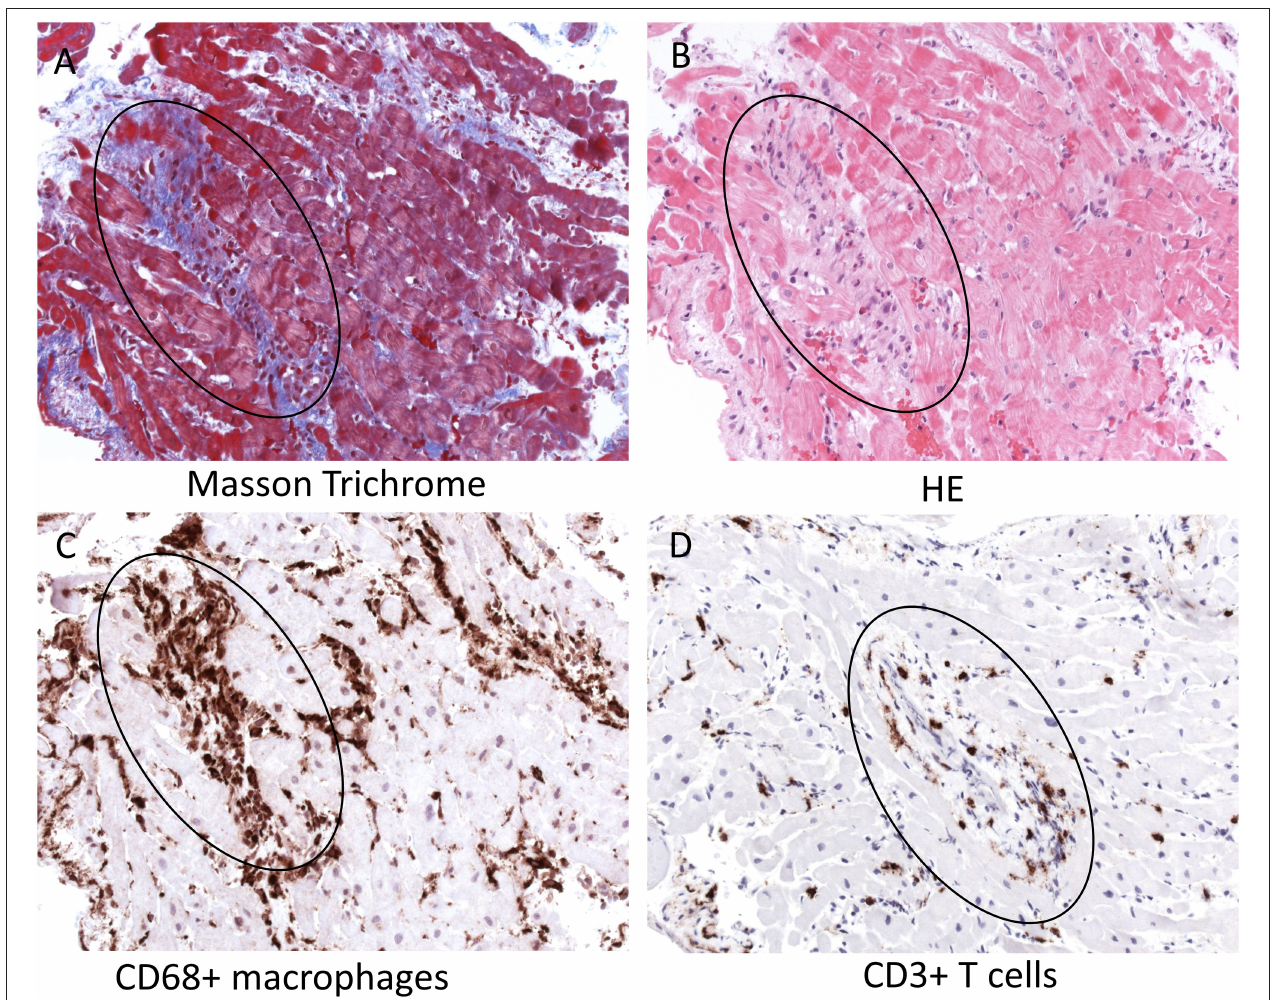
FIGURE 2 | Histopathology and immunohistochemistry of the patient’s endomyocardial biopsy. Serial tissue sections of paraffin-embedded endomyocardial biopsies reveal perivascular fibrosis in absence of myocyte necrosis [Masson Trichrome (A) and HE (B) stainings, see circle] and severe infiltration of CD68 + macrophages (C) and CD3 + T cells (D) primarily around intracardiac small vessels (see circle, magnification x200). HE, hematoxylin-eosin; CD, cluster of differentiation.